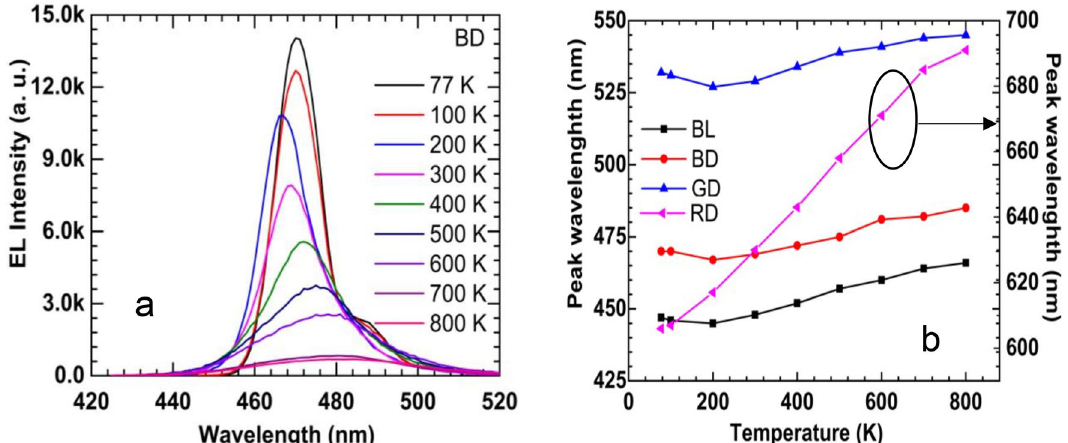
Figure 1. ( a ) Temperature-dependence EL spectra of blue for display under current injection of 0.3 mA. ( b ) Peak positions of EL spectra as a function of temperature for all